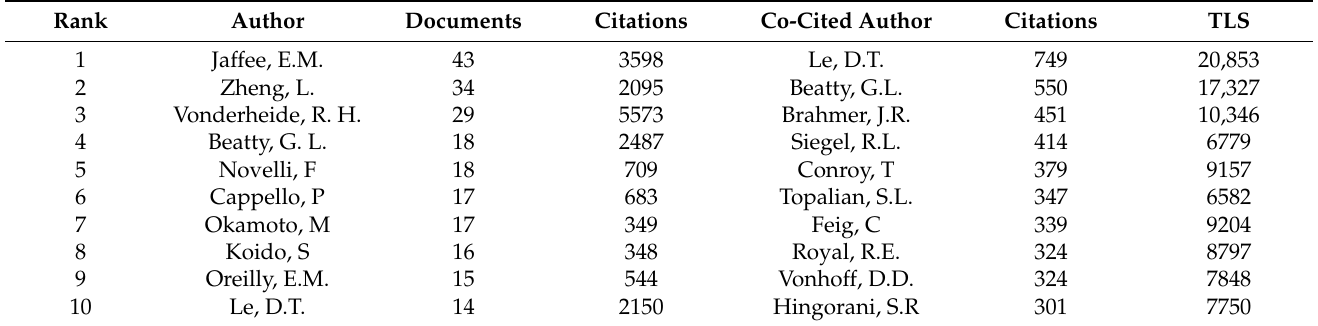
Table 3. The top ten authors and co-cited authors.